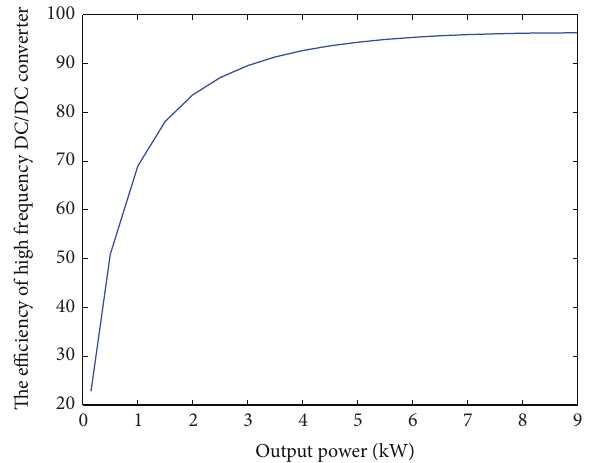
Figure 2: The relationship between efficiency and output